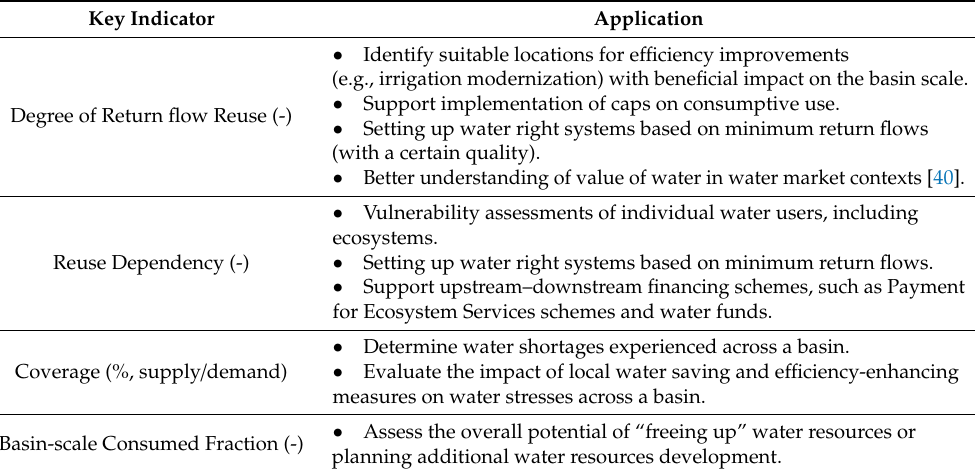
Table 5. Schematic overview of example applications of key indicators quantified with the WEAP-VT